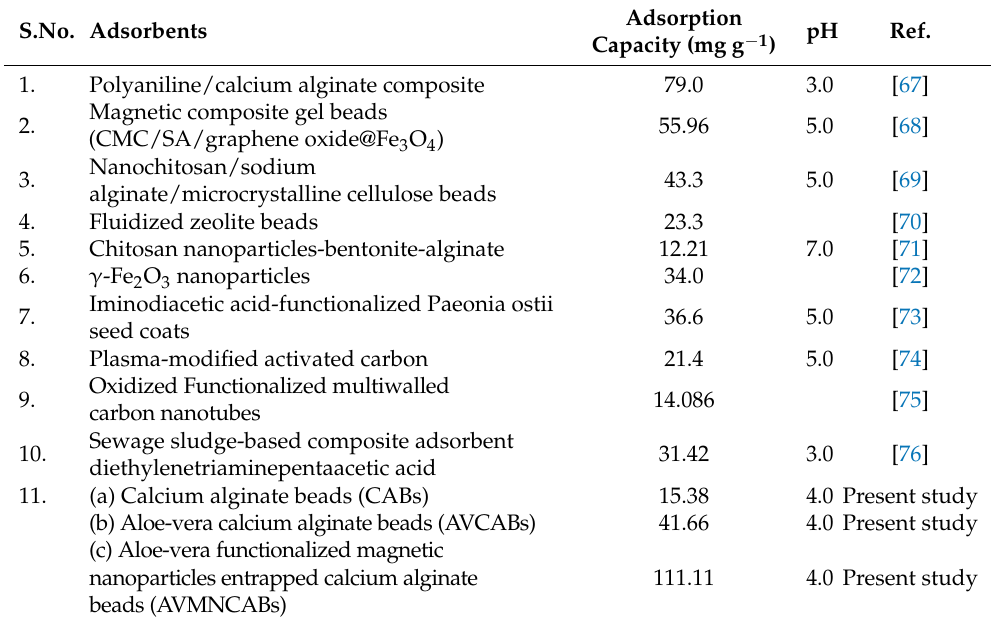
Table 5. Adsorption capacities of different adsorbents—comparison with